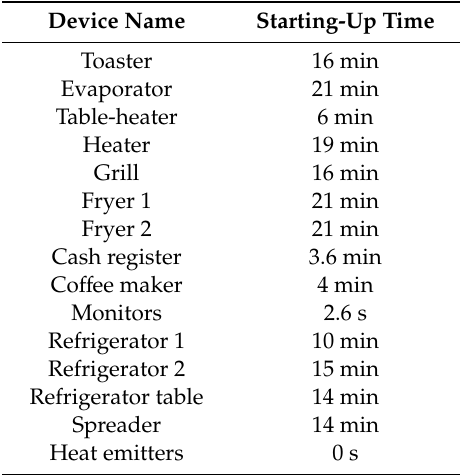
Table 3. Start-up times for individual